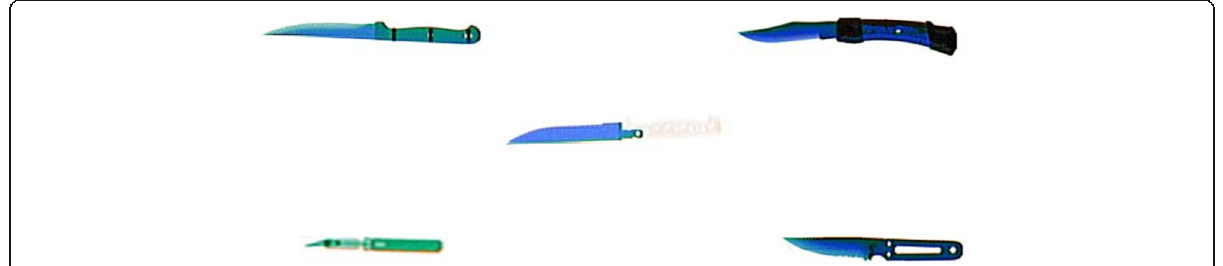
Fig. 2 Image of the five knives that could appear in bags. Before each block of trials, participants were shown this image to familiarize them with potential targets